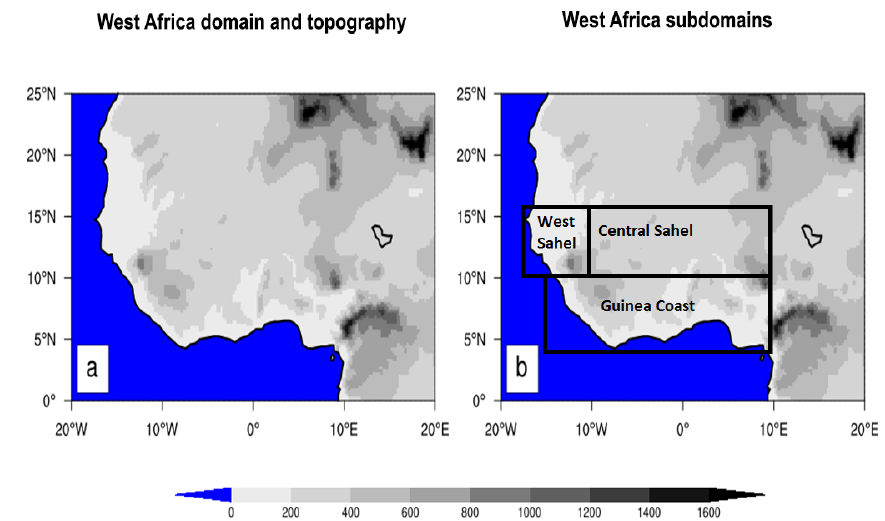
Figure 1. Topography of the West Africa domain. The analysis of the model results has an emphasis on the whole West Africa domain and the three subregions, Guinea coast, Central Sahel and West Sahel, which are marked with black boxes.